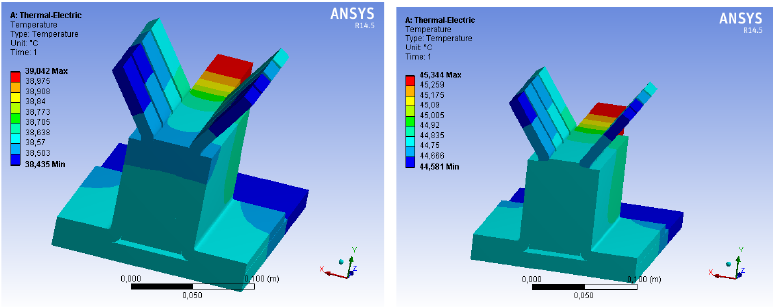
Figure 5. Temperature distribution of direct copper contact without impurities ( left ) and with im ‐ purity resistivity of 1 × 10 –8 Ω m ( right ).